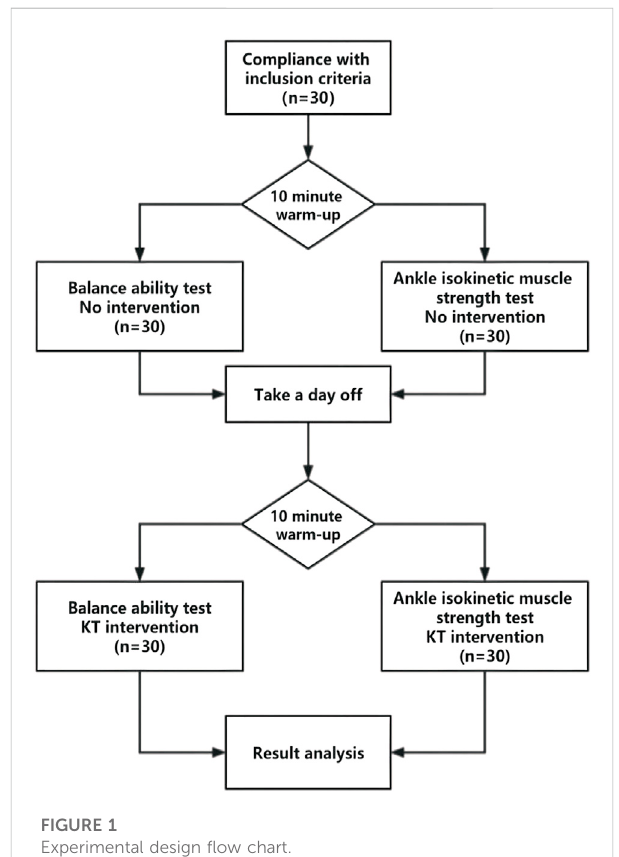
FIGURE 1 Experimental design fl ow